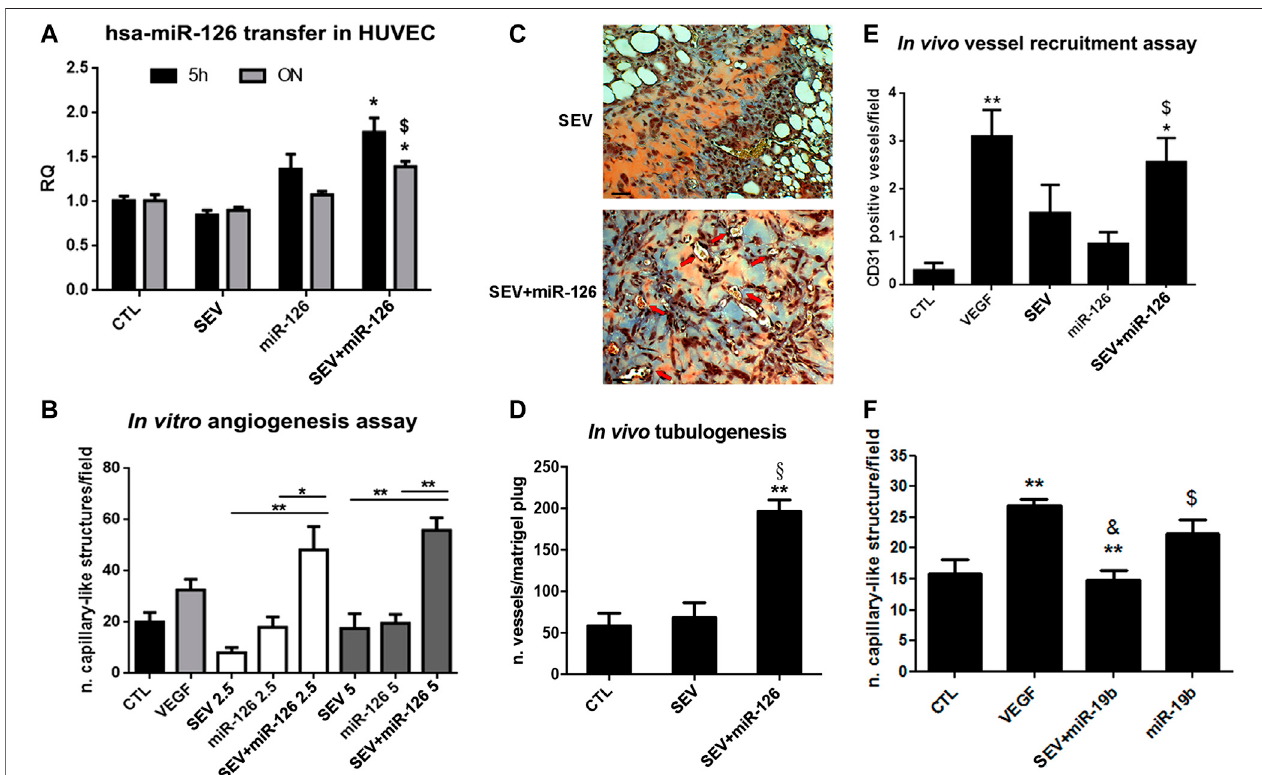
FIGURE 3 | Enhanced angiogenic properties of miR-126 loaded SEVs. (A) miR-126 mimic transfer to HUVEC cells. Cells were treated for 5 h or ON with SEVs, miR-126 or SEV + miR-126 and real time PCR was performed. Data are expressed as Relative quanti fi cation (RQ) ± SD. * p < 0.05 vs. CTL and SEV; $ p < 0.05 vs. miR- 126. (B) In vitro capillary-like structure formation assay. HUVEC were treated with different doses of SEVs (2.5 or 5 × 10 8 p/ml) loaded with miR-126. SEVs and mimic alone were used as internal control. HUVEC treated with VEGF (10 ng/ml) were considered as positive control. Data are expressed as number of capillary-like structure/ fi eld(mean ± SD).* p < 0.05and** p < 0.01vs.SEVormiR-126. (C) RepresentativemicrographoftrichomicstainingofHUVECpre-treatedwithSEV(leftside)or SEV+miR-126(rightside)andinjectedinMatrigelplugs.Thematrigelwasrecoveredafter6 days.Blackbar:50 µm. (D) Tubulogenicassaywascalculatedasaverageof number of vessel structures/matrigel plug (mean ± SD) * p < 0.05 vs. CTL; § p < 0.05 vs. SEV. (E) In vivo mouse model ofvessel recruitmentby SEV, SEV + miR-126and miR-126 embedded in Matrigel plug. Data are expressed as CD31 positive vessels/ fi eld (mean ± SD). * p < 0.05 and ** p < 0.01 vs. CTL; $ p < 0.05 vs. miR-126.